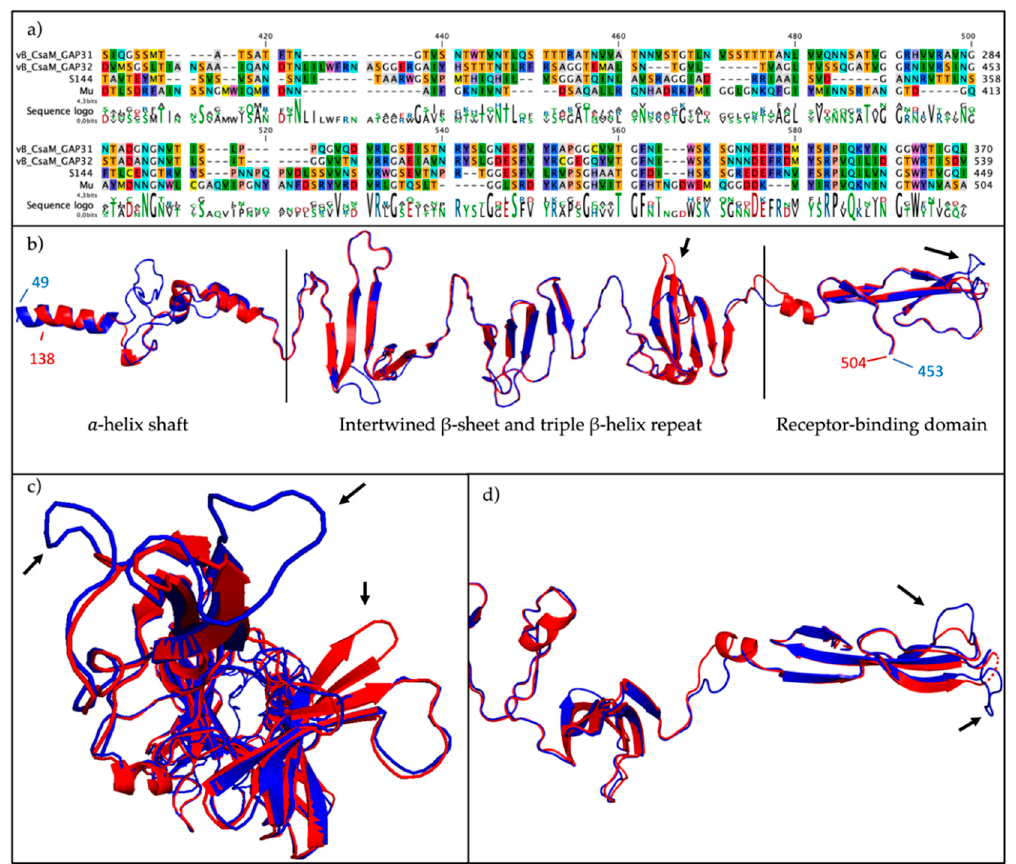
Figure 3. Sequence and structural alignment of the predicted S144 tail fiber protein. ( a ) Sequence alignment of the C-terminal residues of the tail fibers from phages S144, GAP31, GAP32 and Mu G + . ( b ) Structural comparison by superposition of the experimental resolved tail fiber protein from phage Mu G + (red; PDBID:5YVQ) and the predicted S144 tail fiber (blue) (RMSD 1,2 Å over 348 matched residues, TM-score 0.843) with the three domains determined in Mu’s tail fiber, ( c ) from the distal end and ( d ) zoom in of the C-terminus, involved in the cell surface binding. The arrows indicate structural differences between the two tail fibers.